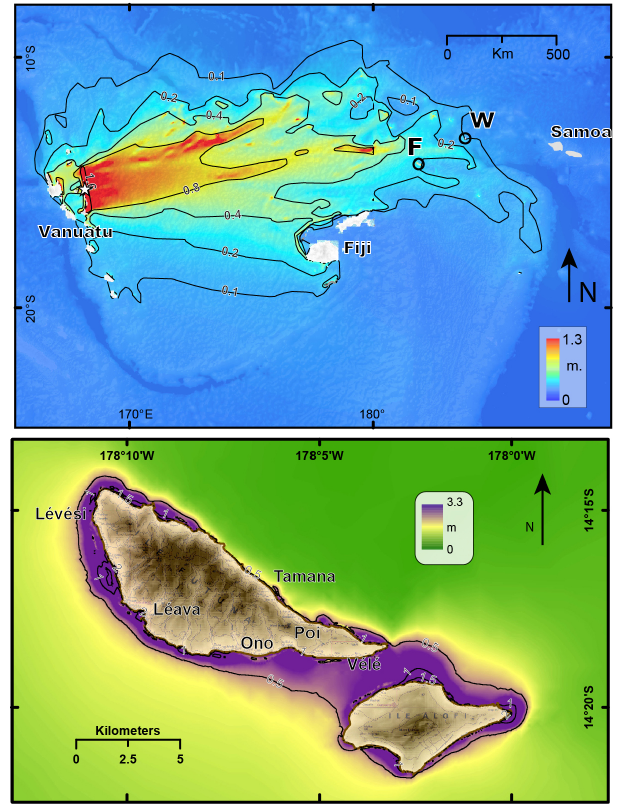
Figure 14. Maximum wave elevation (in m) from the source (top) and at Futuna (bottom) from a tsunami generated along the Vanuatu Back Arc (Sc. 14, Table 4). Star on top image is epicentre.